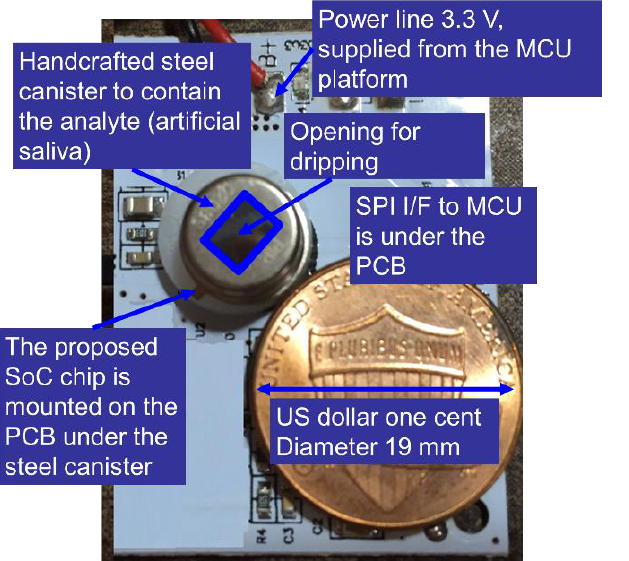
Figure 19. The system view of the proposed biosensor with integrated readout circuit on the FR4 print-circuit-board.